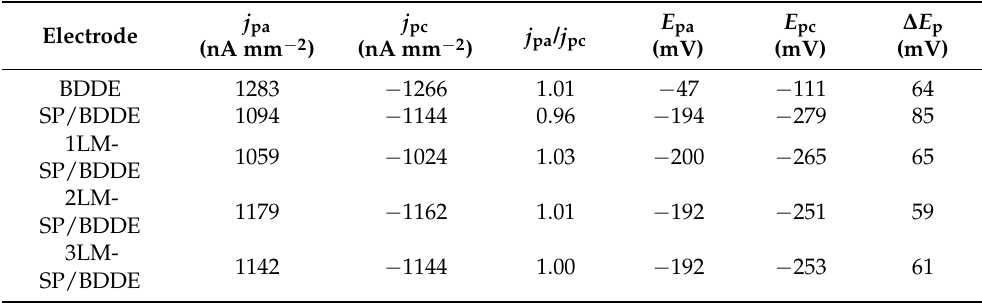
Table 3. Parameters of the cyclic voltammograms of redox market [Ru(NH 3 ) 6 ] 2+/3+